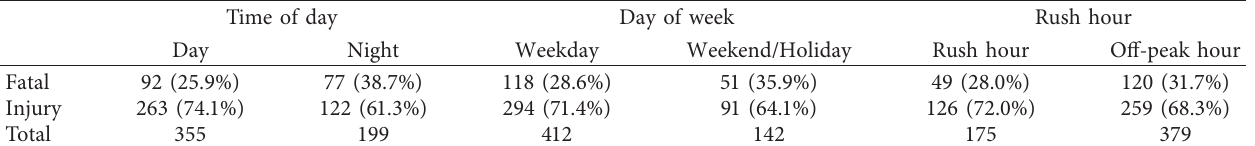
Table 2: Statistical information of time-related factors for injury severity.